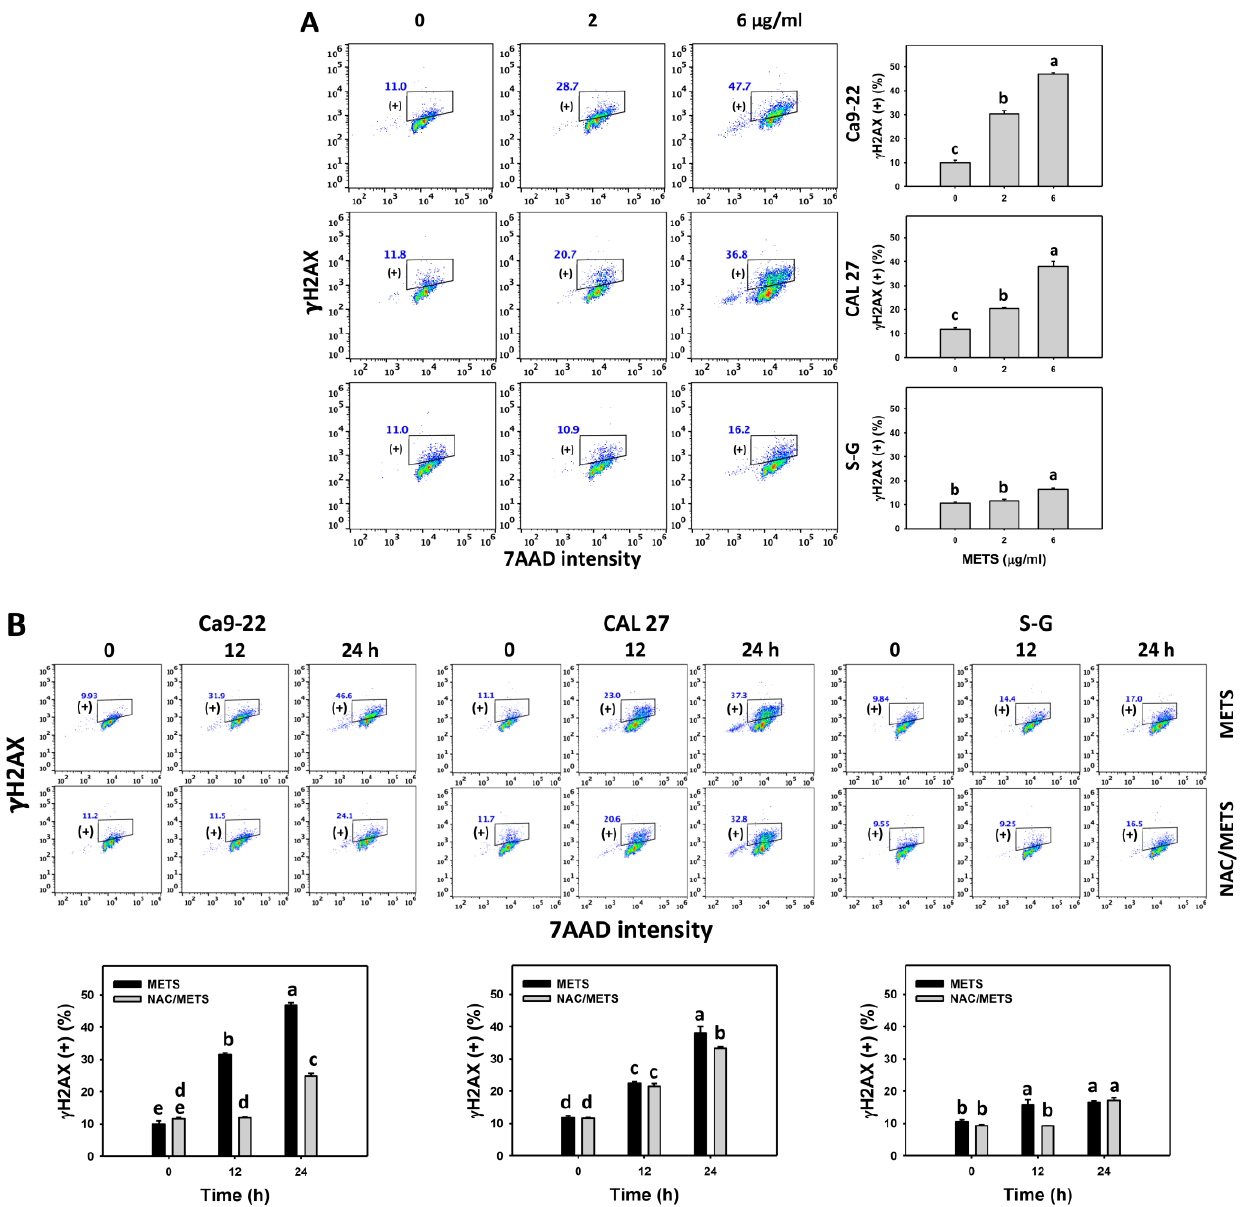
Figure 9. METS enhances the γH2AX level of oral cancer cells. ( A ) γH2AX histogram changes. Cells were treated with METS for 24 h. Oral cancer and normal cells (S-G) were included. (+) indicates the high intensity of γH2AX. ( B ) NAC response on γH2AX levels. Untreated control and NAC pretreatment were followed by posttreatment of vehicle control and METS (6 μg /mL) for 0, 12, and 24 h, i.e., control, NAC, METS, and NAC/METS, respectively. Data = mean ± SD ( n = 3). Data showing non-overlapping lower-case letters have significant results ( p < 0.05) as analyzed by the one-way ANOVA analysis and post hoc test.